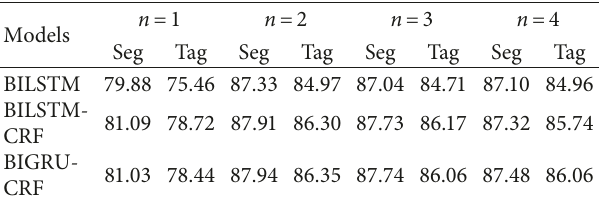
Figure 6: The knowledge map construction process of English classic literature works. Table 2: F1 values of n-gram embeddings on the development set. Table 1: Hyperparameter settings-(a).